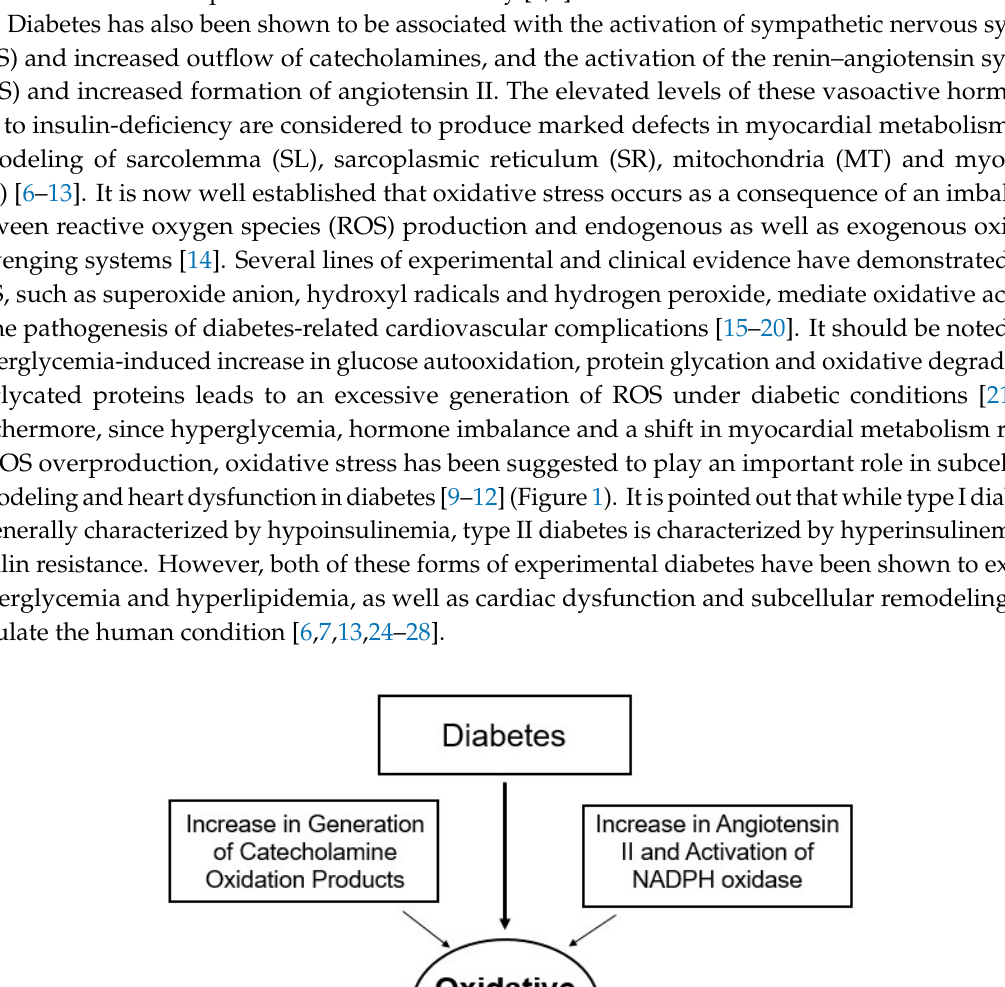
Figure 1. Role of oxidative stress in the pathogenesis of diabetic cardiomyopathy.